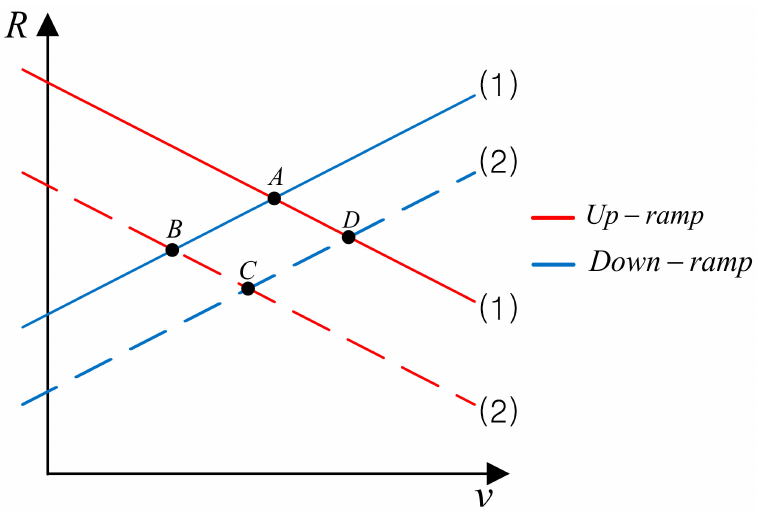
Figure 3. Example of multi-target problem in R - v